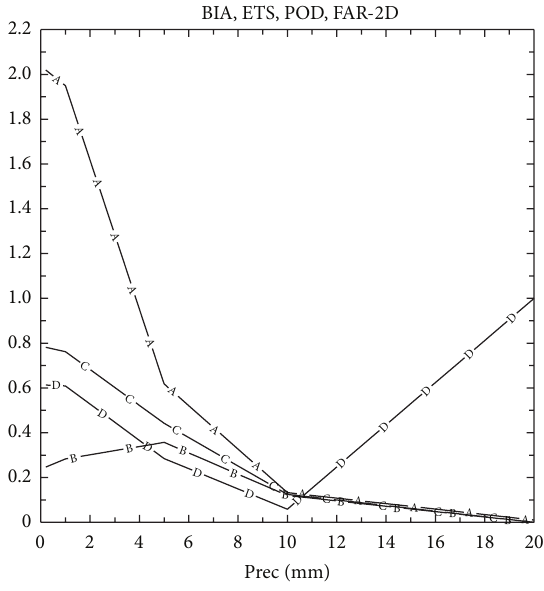
Figure 12: As in Figure 11 but for